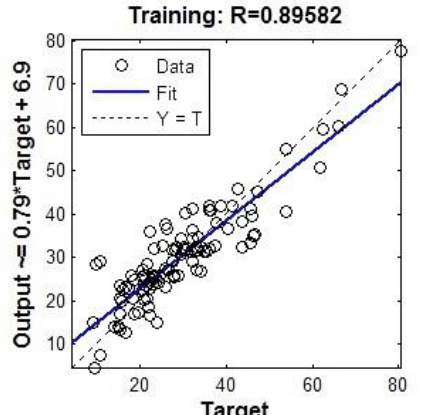
Fig. 13. Relationship between Target and Output Values in Training Step of ANN Modeling with 15 Hidden Neurons.